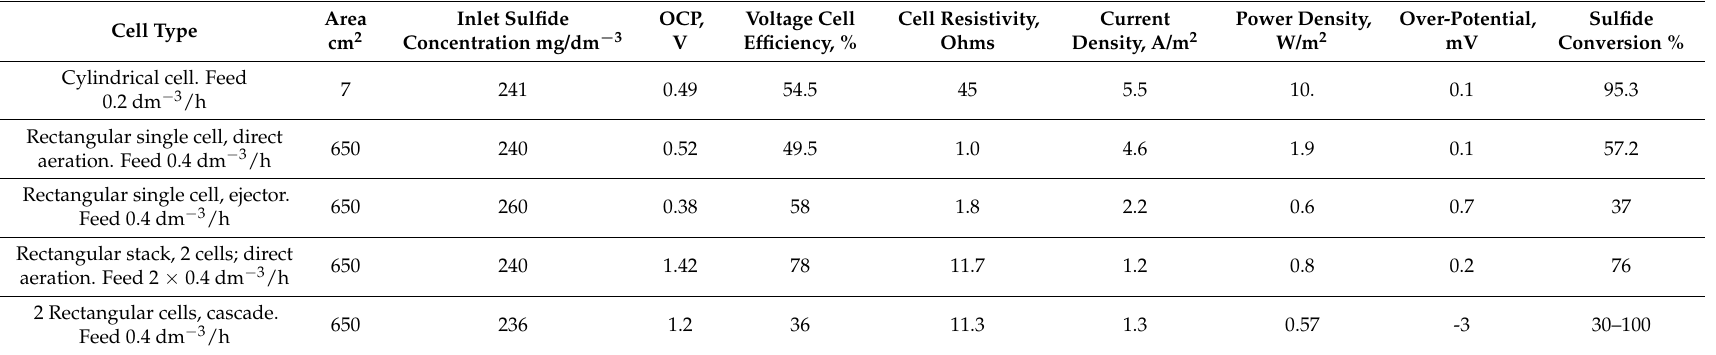
Table 5. Comparison of selected experiments with different fuel cell geometry, size, feed flow rate, and flow organization. Membrane Celgard